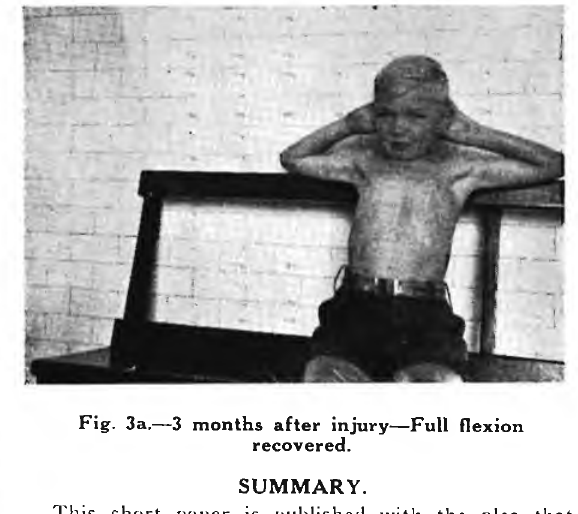
Fig. 3a.—3 months after injury—Full flexion